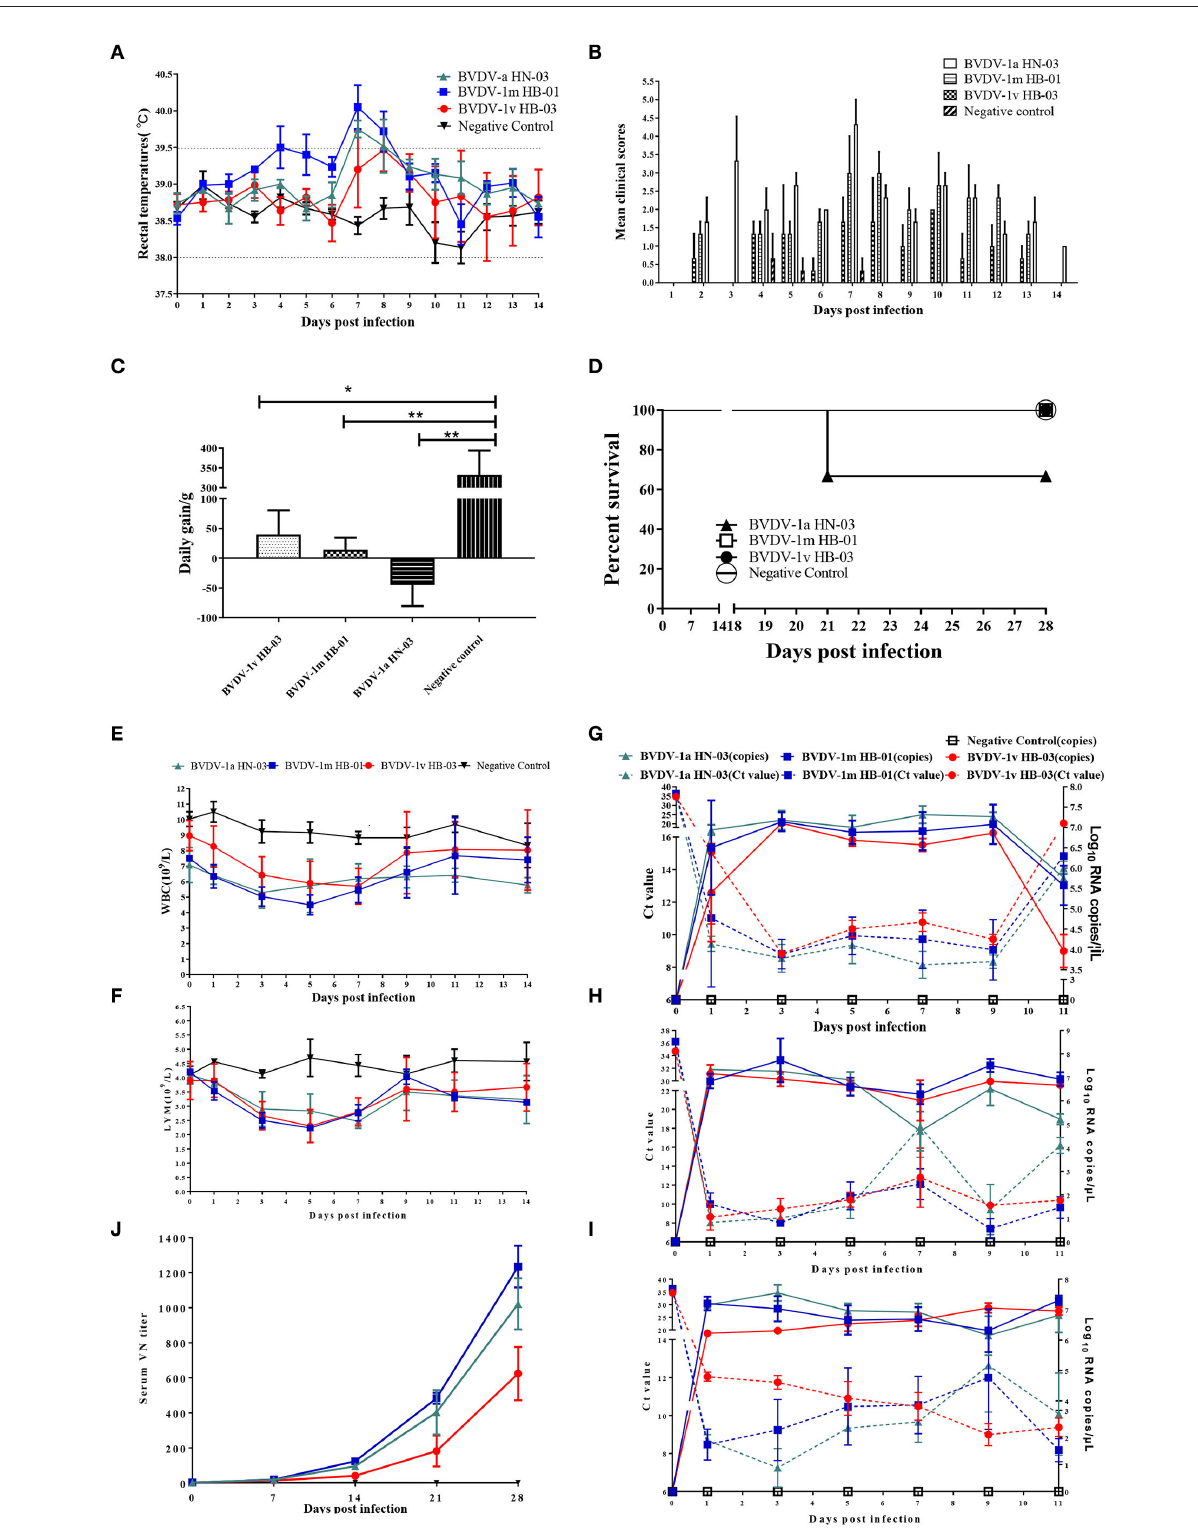
FIGURE8 Evaluation of the three bovine viral diarrhea virus (BVDV) isolates’ pathogenic and serological characters. (A) Fever (B) , clinical signs (C) , average daily weight gain (D) , and survival rate (E) of all calves were monitored daily. Hematology of calves infected with BVDV isolates was measured at 0–14 dpi. Mean number expressed as mean ± standard error for white blood cell (WBC) (E) and lymphocytes (LYM) (F) . Relative quantification of virus load in blood (G) , nasal swabs (NSs) (H) , and rectal swabs (RSs) (I) provided insights into the viral load of the virus following intranasal infection. Serum neutralizing antibody titers were tested at 0, 7, 14, and 28 dpi (J) . Significant differences are indicated with asterisks (* p < 0.05, ** p <